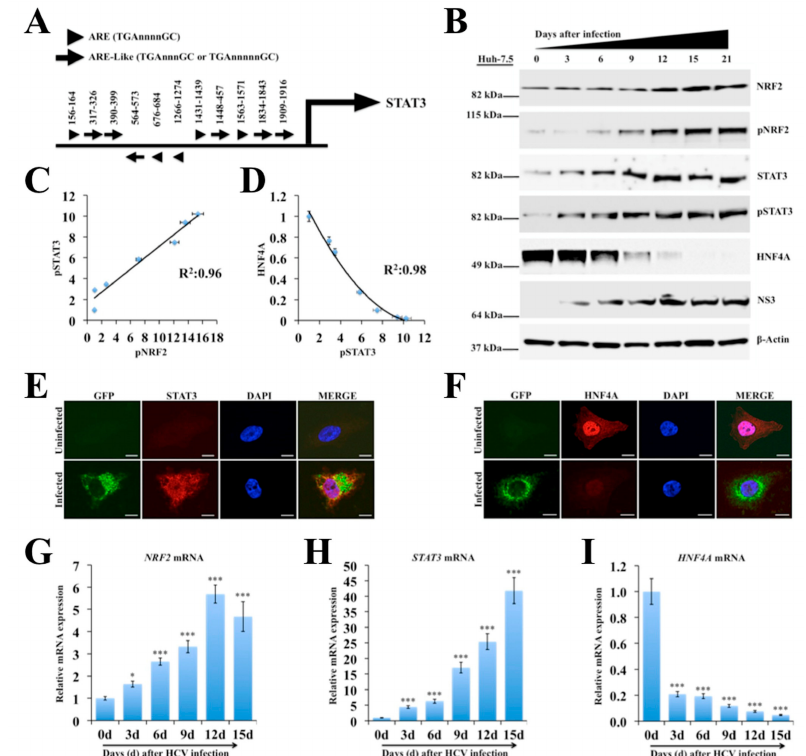
Figure 1. Persistent hepatitis C virus (HCV) replication induces nuclear factor erythroid 2-related factor 2 (NRF2)-mediated regulation of the signal transducer and activator of transcription 3 (STAT3)-hepatocyte nuclear factor 4 alpha (HNF4A) inflammatory loop. ( A ) STAT3-promoter region was examined for the presence of antioxidant response element (ARE) consensus sequences indicated by arrowheads, and ARE-like sequences shown by arrows. ( B ) Western blot analysis shows expression levels of total and phosphorylated NRF2, and STAT3 in infected Huh-7.5 liver cells over 21 days. The expression of HNF4A was inversely correlated with HCV NS3 protein expression. ( C ) Band intensities of phosphorylated STAT3 (pSTAT3) and phosphorylated NRF2 (pNRF2) were quantified using ImageJ software and R 2 values were determined by excel software. ( D ) Western blot results of HNF4A and pSTAT3 were quantified using ImageJ software and R 2 values were determined by excel software. ( E ) Colocalization of HCV-green fluorescence protein (GFP) with STAT3 by confocal microscopy. ( F ) Colocalization studies by confocal microscopy between HCV-GFP and nuclear expression of HNF4A in infected Huh-7.5 cells on day 9. Messenger RNA (mRNA) levels of individual genes in HCV-infected Huh-7.5 culture were measured by real-time RT-PCR analysis. ( G ) NRF2 mRNA levels ( H ) STAT3 mRNA levels. ( I ) HNF4A mRNA levels. The results are expressed as the mean ± standard deviation (SD) of three experiments. Error bars represent SD. p -values were calculated by ANOVA as compared to uninfected control. * p -value < 0.05, *** p -value < 0.001. Original magnification × 60. Scale bars = 10 µ